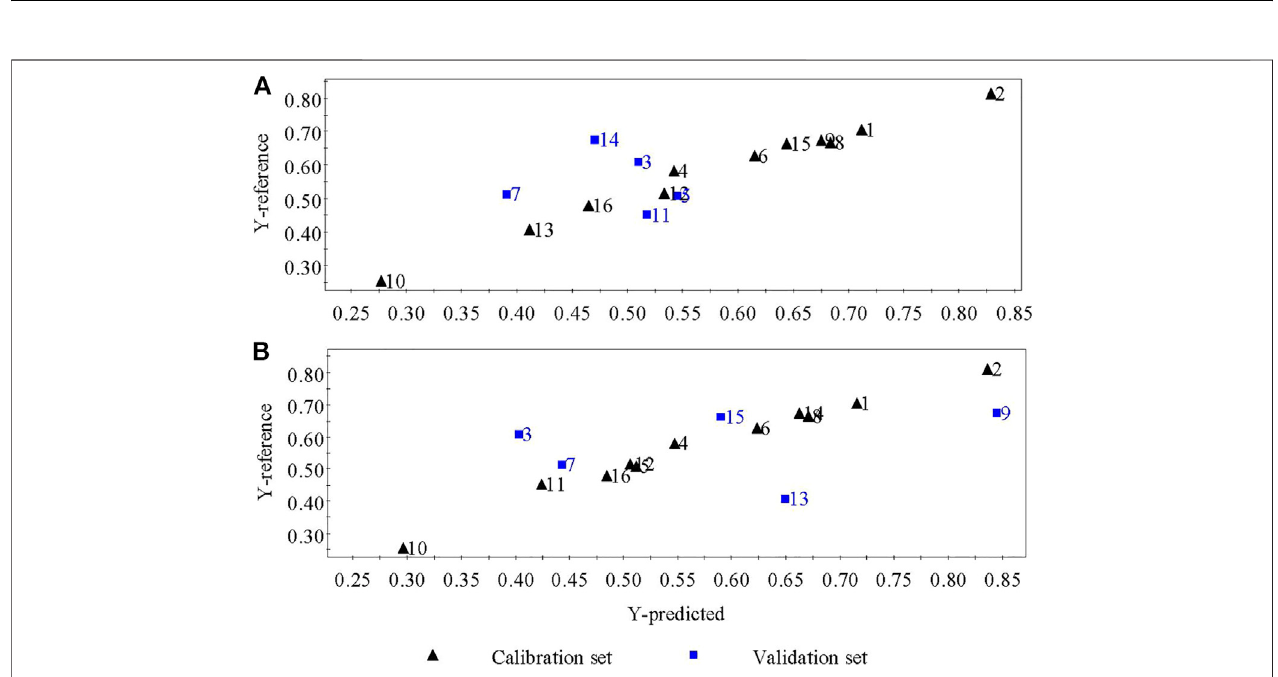
FIGURE 4 | Predicted results of the OSC – PLSR model grouped using the KS (A) and SPXY methods (B) .